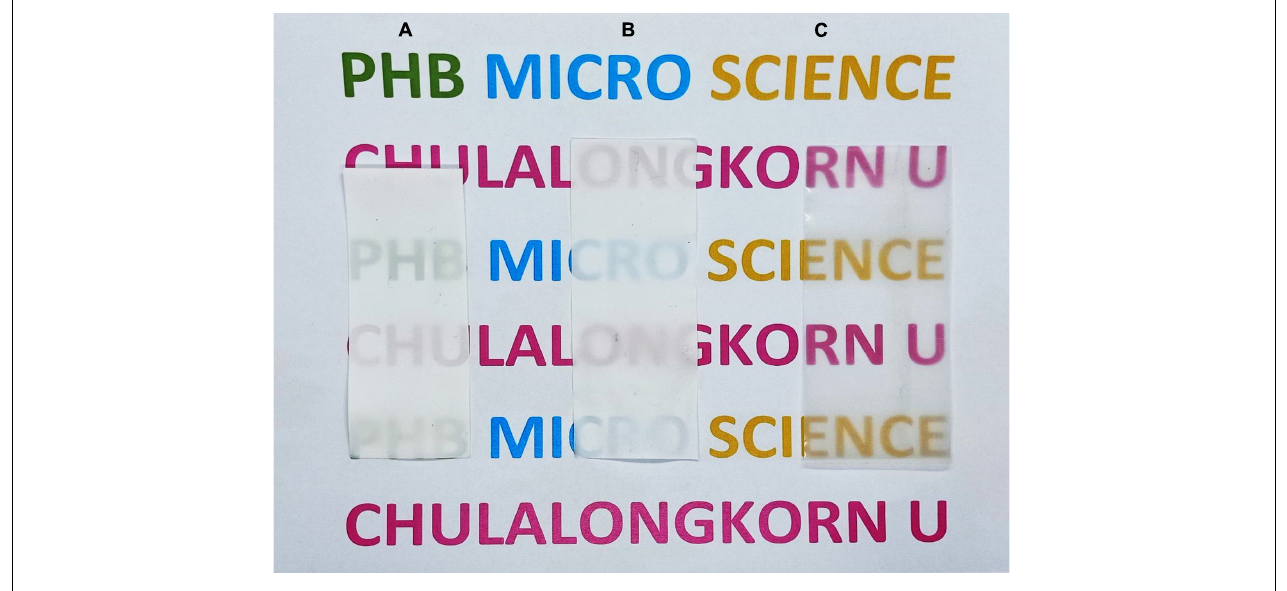
FIGURE 7 | Morphology of PHB films produced by (A) C. necator strain A-04, (B) E. coli JM109 (pColdI- phaCAB A - 04 ), and (C) E. coli JM109 (pColdTF- phaCAB A - 04